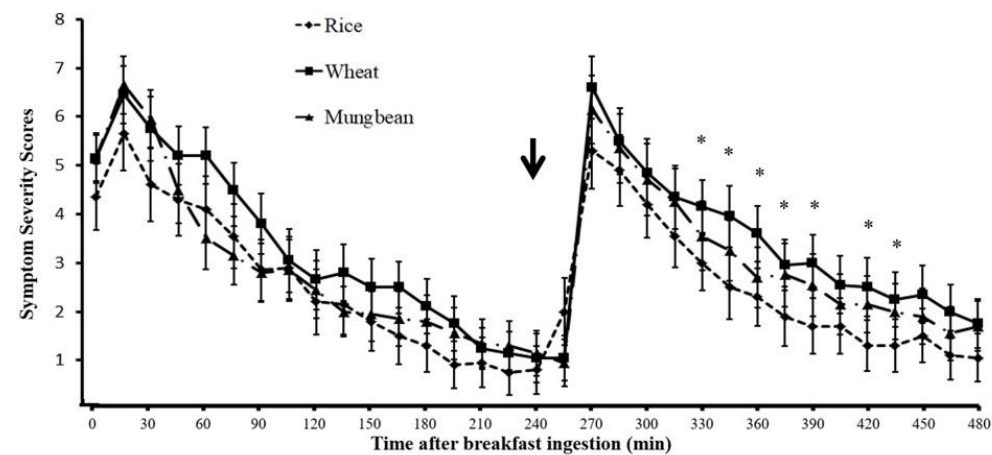
Figure 5. Satiety symptom severity score at baseline and every 15 min after breakfast until the end of the breath test study (data expressed as mean ± SEM) (arrow = time of lunch ingestion); * = p < 0.05 wheat vs. rice.